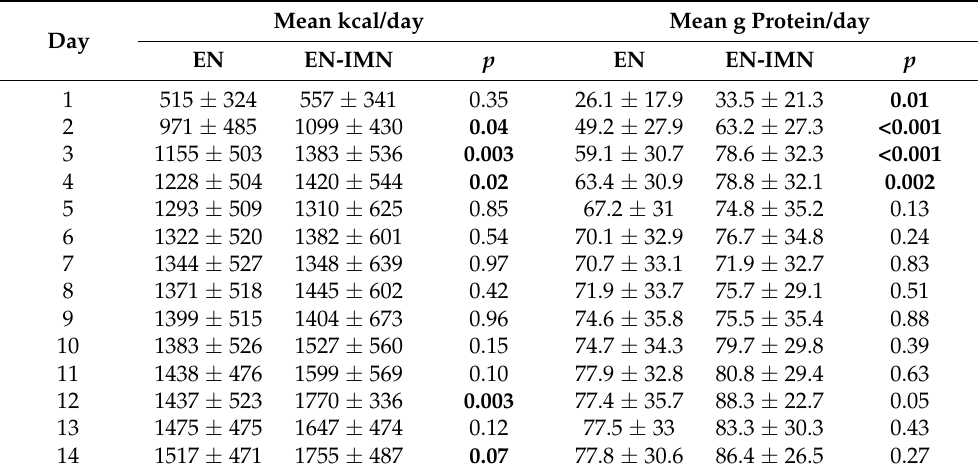
Table 3. Mean caloric and protein delivery during enteral nutrition